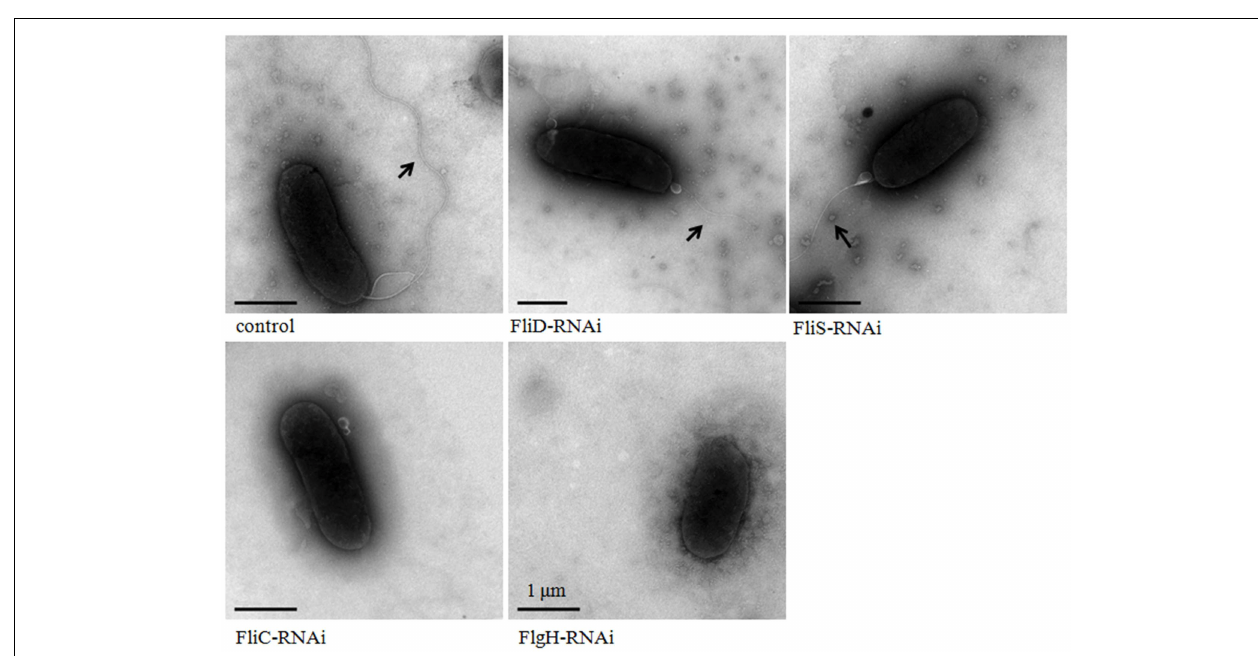
FIGURE 5 | Transmission electron micrographs of stable silenced V. alginolyticus strains. The arrow indicates the flagellum.